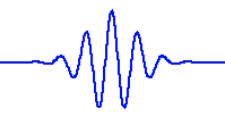
Figure 2. The Morlet wavelet